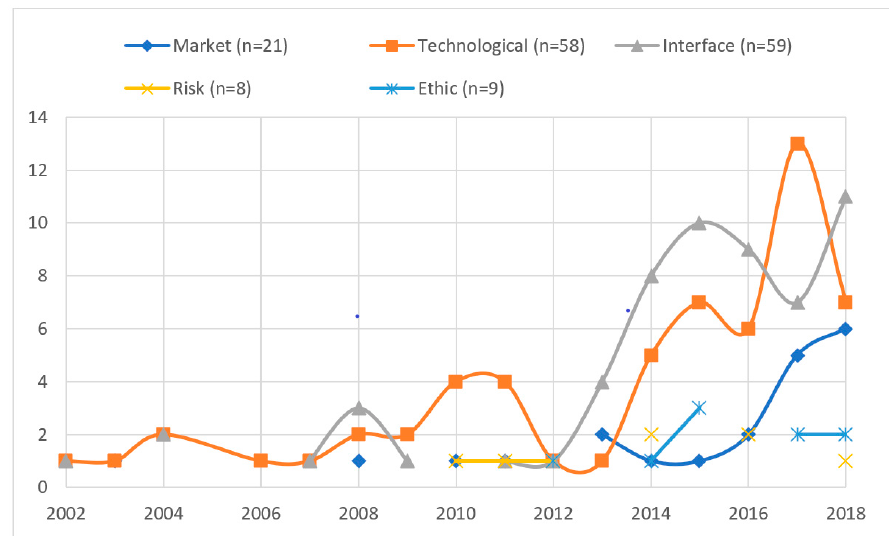
Figure 2. Chronological evolution of publications per frame (results before 2002 and after 2018 were discarded).